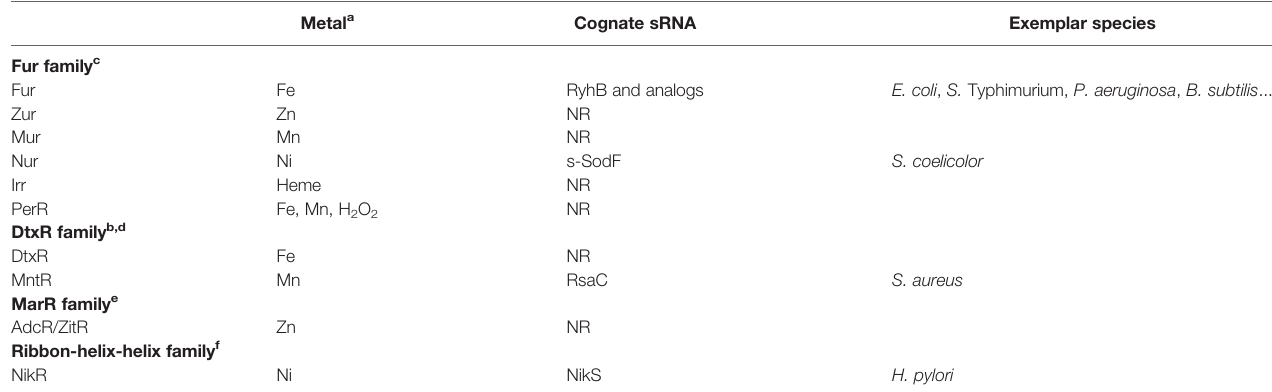
TABLE 1 | Transcription factors and sRNAs that respond to metal